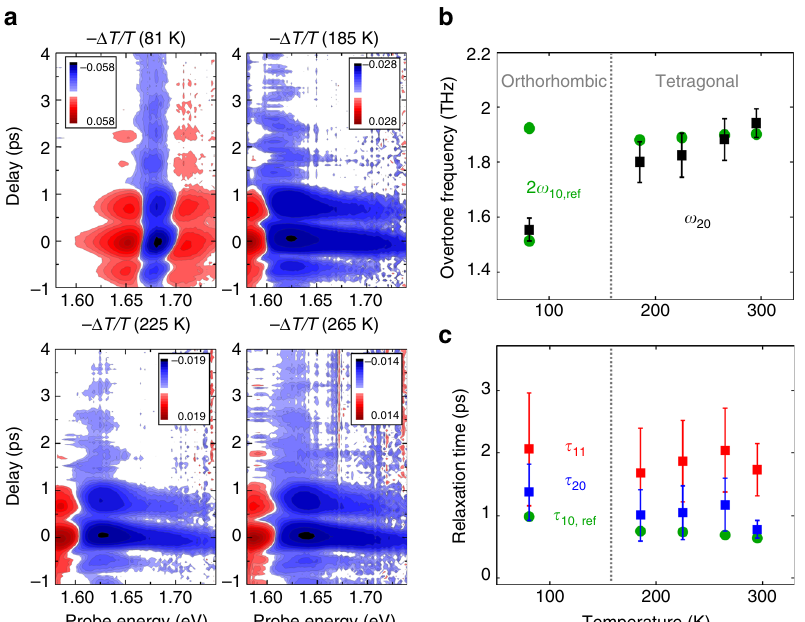
Fig. 4 Temperature dependence of the phonon-gap coupling. a The THz pump visible probe spectra at different temperatures: 81, 185, 225, and 265 K. b The temperature dependence of the overtone frequency ( black squares ) obtained by the damped oscillator fi t of the data (SI) after the instantaneous response disappears and the reported fundamental dephasing time 20 multiplied by 2 ( green circles ). c The temperature dependence of the population relaxation ( red squares ) and the overtone dephasing time ( blue squares ) compared with the reported fundamental dephasing time ( green circles ) 20 . b – c The gray dashed line indicates the temperature where the phase transition between the orthorhombic and the tetragonal structure occurs. The error ranges correspond to the weighted standard deviation of each parameter at different detection energies (for further details see Methods section)